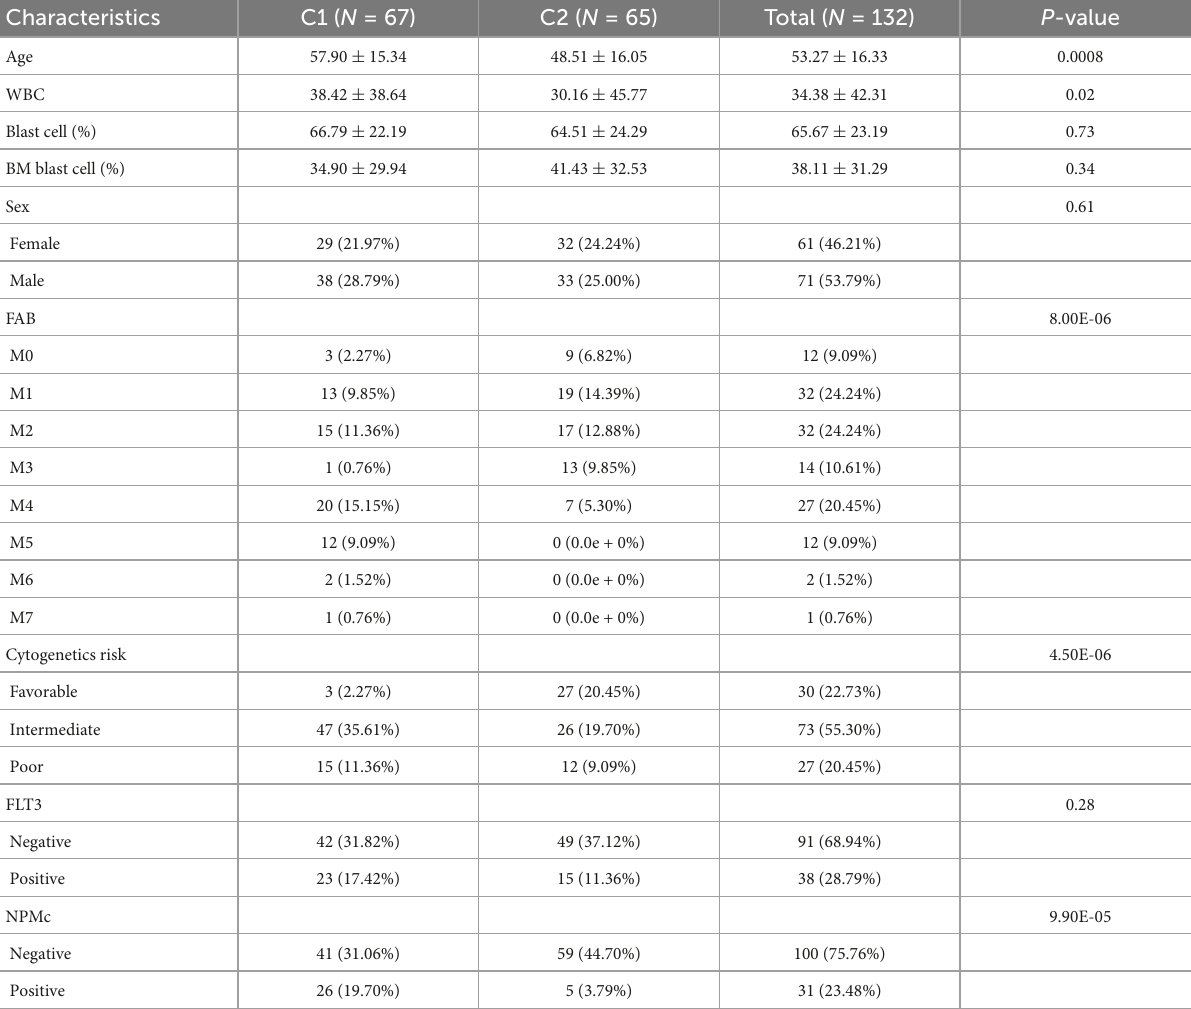
TABLE 1 The characteristics of 132 acute myeloid leukemia (AML) patients between two clusters.